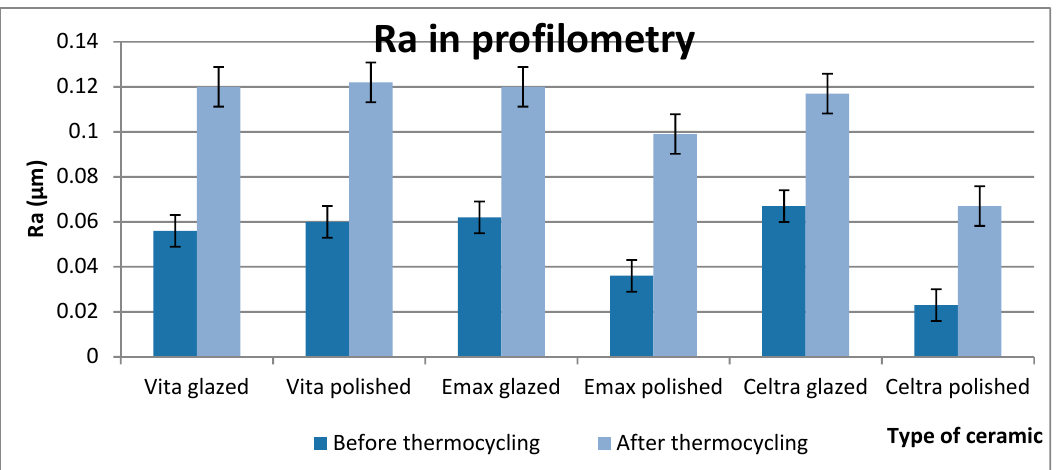
Figure 1. Mean and standard deviation values for average surface roughness before and after thermocycling.